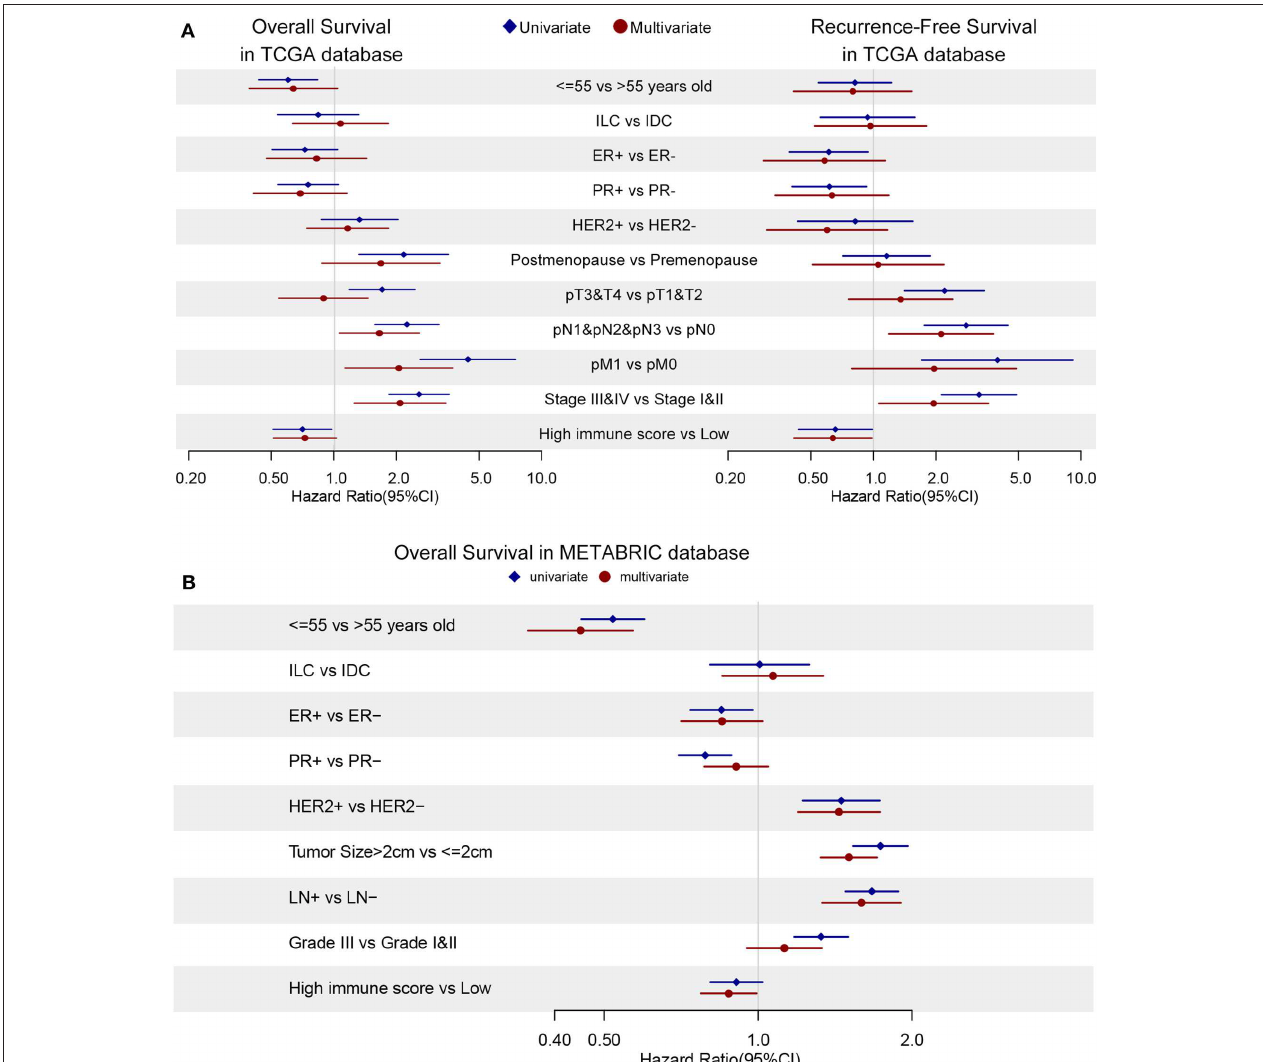
FIGURE 7 | The cox regression is applied to discover hazard ratios (HRs) of clinical characteristics and immune scores in OS (left) and RFS (right) in TCGA database (A) and OS in METABRIC database (B) . Blue diamonds and red dots demonstrates univariate and multivariate analysis, respectively. The confidence intervals are shown as the length of the line. Lines cross HR = 1.0 indicates their